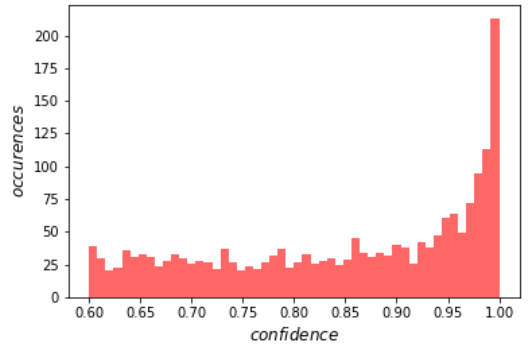
Figure 8. Confidence level histogram The threshold was set to 99.9%, leaving just 15 positives inside the region of interest delimited by the moat of the historical site. In total 8 true positives are allocated to 4 dummies and 7 false positives are allocated to 4 other objects. All the dummies were detected, but it is clear the model does not only detect dummies. High contrast areas are common false positives (see Figure 9).